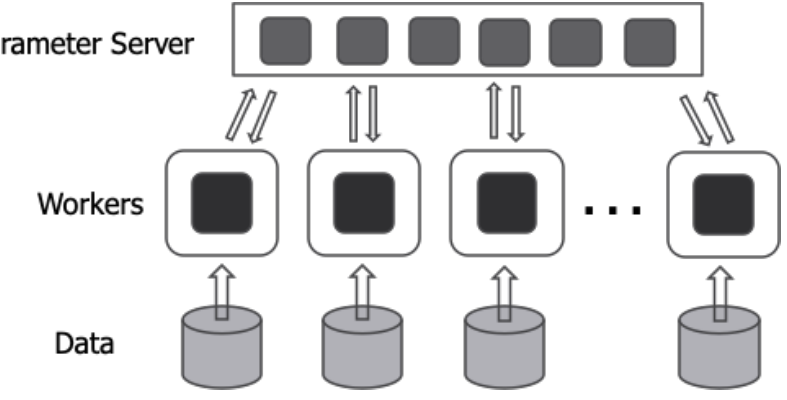
Figure 2. Parameter server